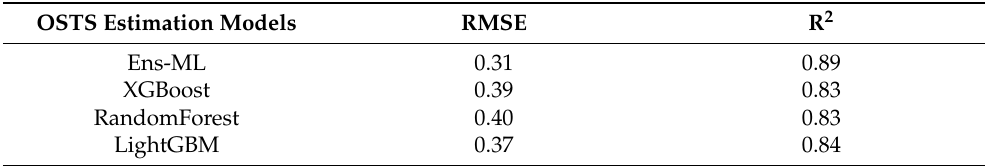
Table 3. The performance comparison of different models for OSTS estimation per calculated yearly mean RMSE ( ◦ C) and R 2 Values.